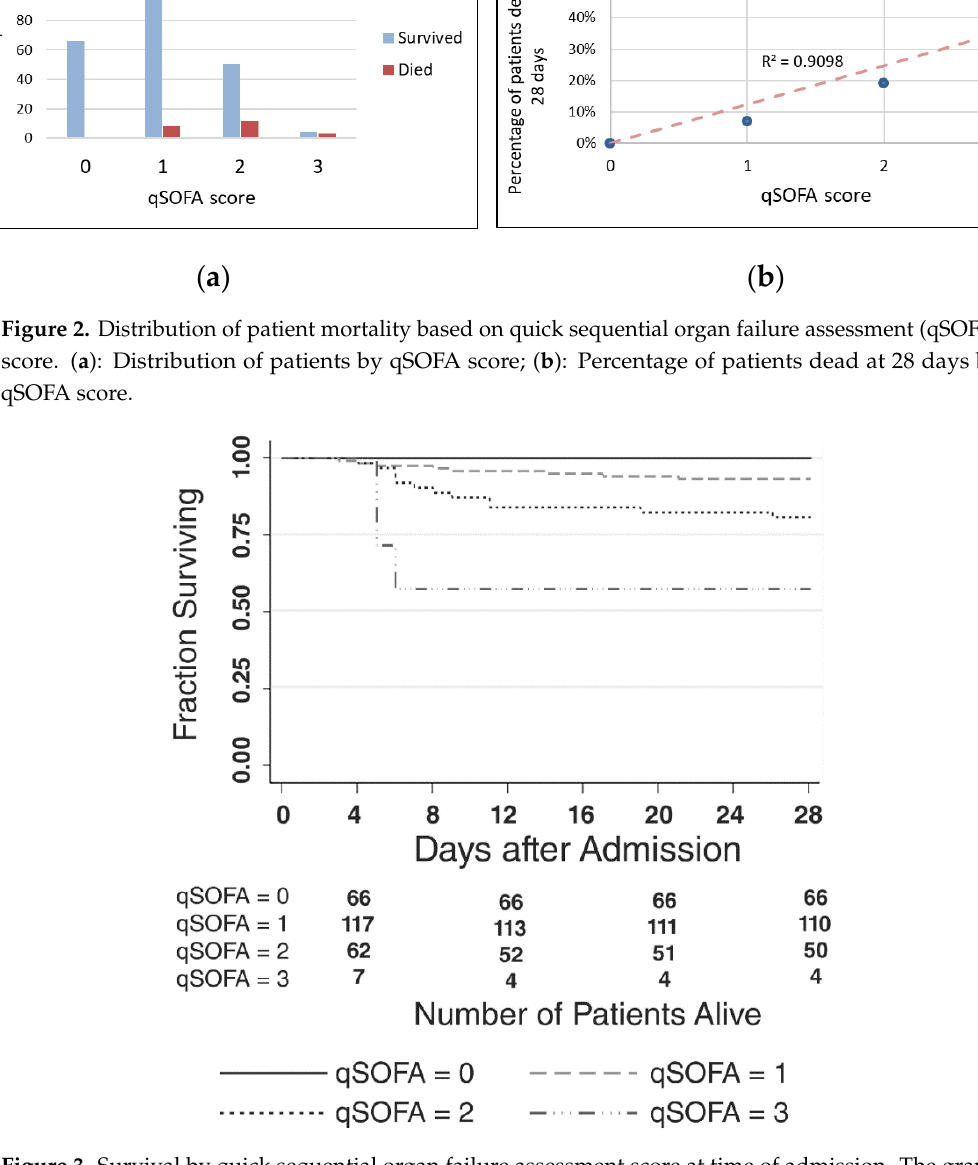
Figure 3. Survival by quick sequential organ failure assessment score at time of admission. The graph demonstrates the fraction of patients surviving over 28 days based on qSOFA. score. The table below indicates the number of patients alive within each qSOFA cohort at days 4, 12, 20, and 28. A baseline risk model for mortality was developed using age, sex, cardiac disease, and liver disease. The AUROC for the baseline risk model alone was 0.62 (95% CI, 0.49–0.75). To quantify predictive validity, the qSOFA score was added to the baseline risk model to determine excess mortality above and beyond the baseline risk model. The addition of qSOFA score to the baseline risk model significantly increased the AUROC to 0.80 (95% CI, 0.70–0.89; p < 0.001 for di ff erence, Figure